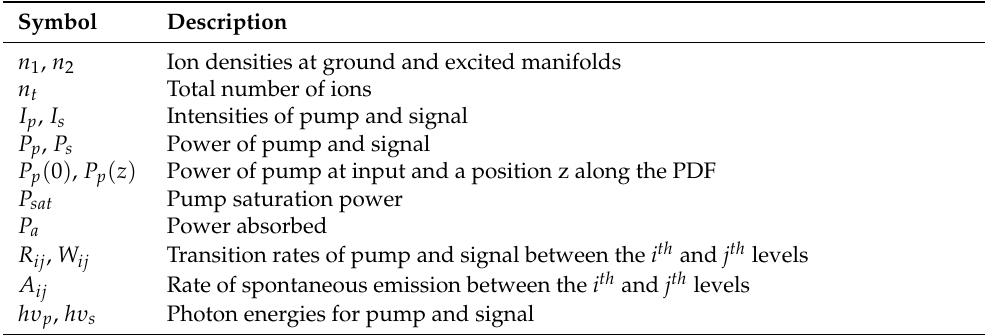
Table 2. Symbols used in Equations (1)–(12) and their